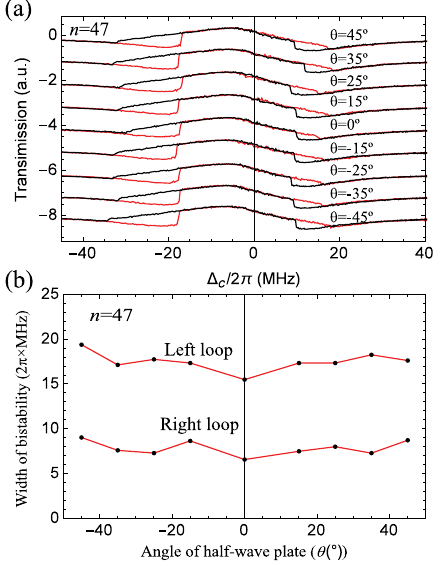
FIG. 11. (a) Recorded spectra for different polarization of the coupling beam ( n ¼ 47 ). The red or black line corresponds the þ ( − ) scan direction from red to blue detunings (red) and vice versa (black). Note that θ is defined as the angle of a half-wave plate inserted in the optical path of the coupling beam. (b) Angular dependence of hysteresis width for n ¼ 47